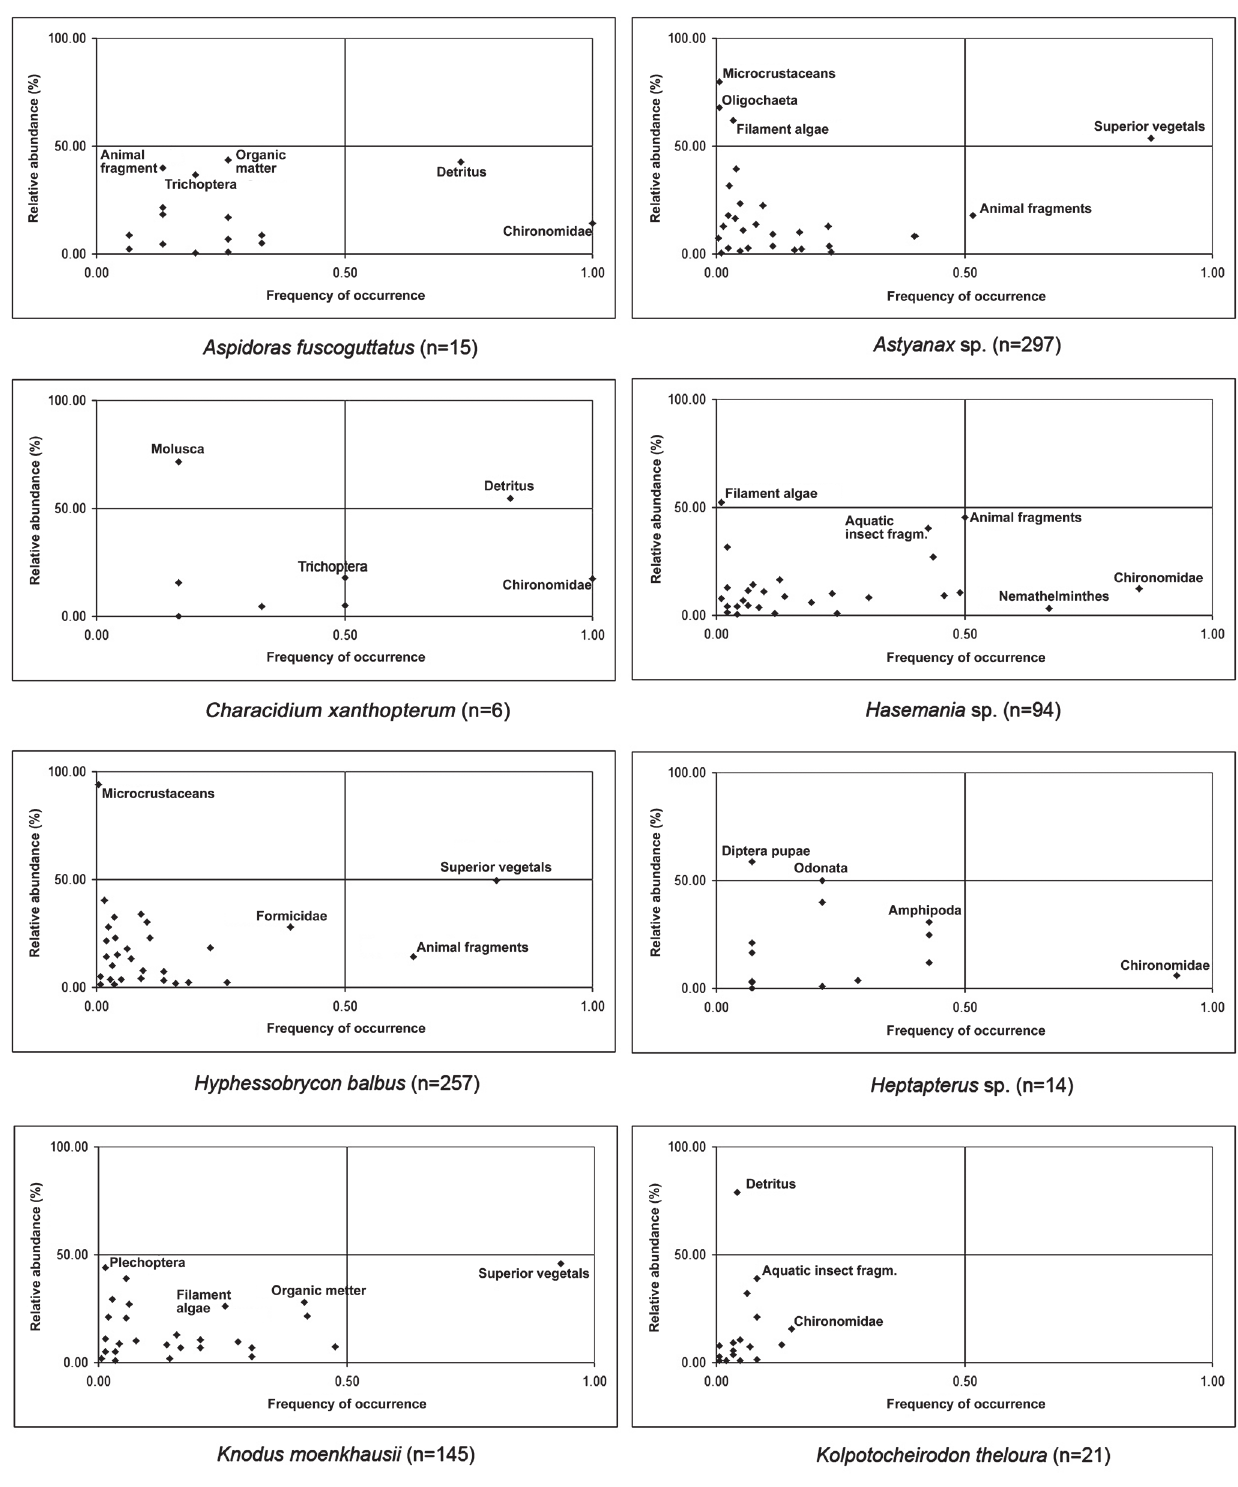
Fig. 4. Feeding items distributed according to the frequency of fish species occurrence (axis X) and relative abundance (axis Y), based upon the method proposed by Amundsen et al (1996): Aspidoras fuscoguttatus, Astyanax sp. , Characidium xanthopterum, Hasemania sp. , Hyphessobrycon balbus, Heptapterus sp. , Knodus moenkhausii and Kolpotocheirodon theloura . The number of analyzed stomachs is shown in